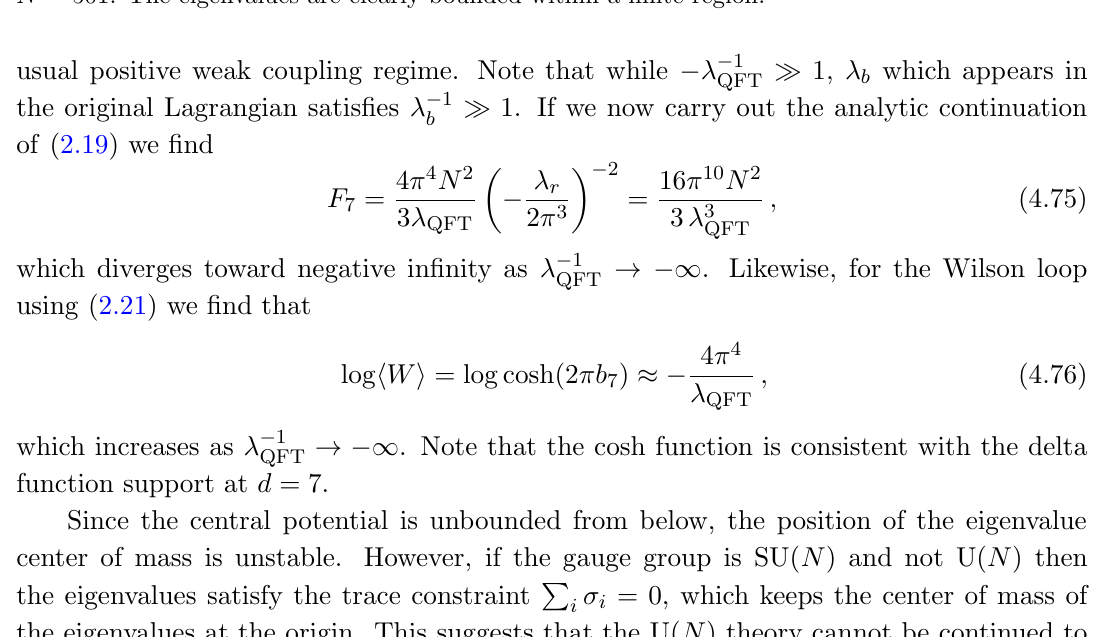
Figure 7 . Distribution of eigenvalues obtained from (2.6) numerically for d = 7, (cid:21) (cid:0) 1 N = 501. The eigenvalues are clearly bounded within a (cid:12)nite